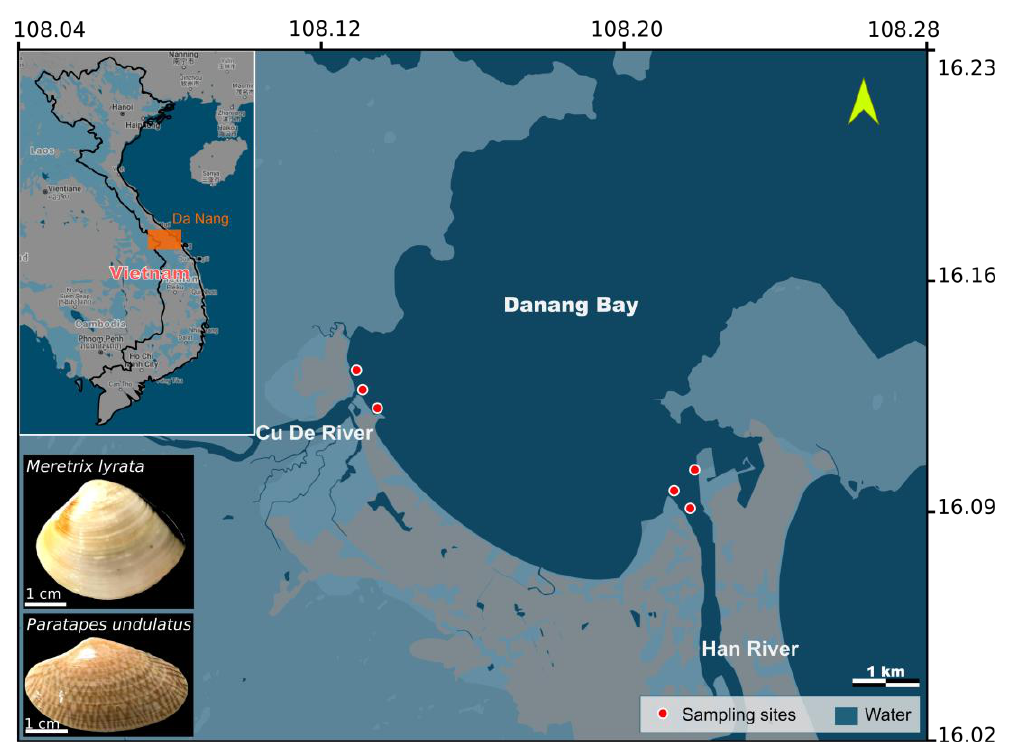
Figure 1. Sampling sites and photos of the two bivalve species. Table 1. Information of two bivalve species collected from coastal Da Nang. Species